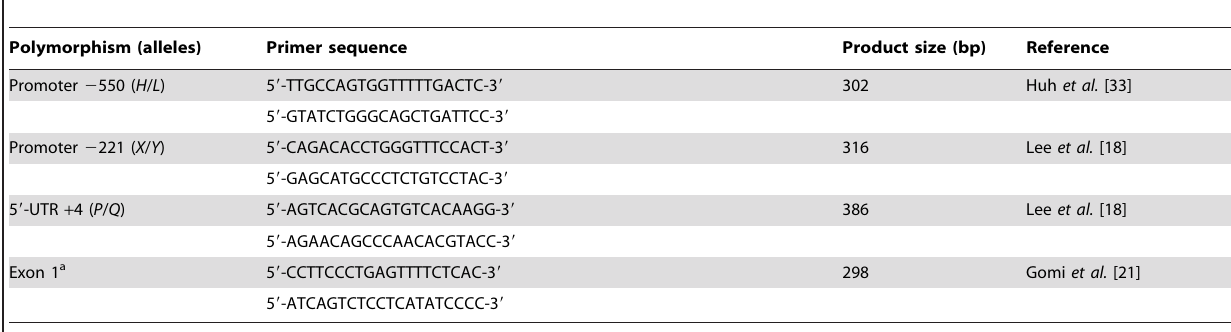
Table 1. PCR primers used in the analysis of the MBL2 gene